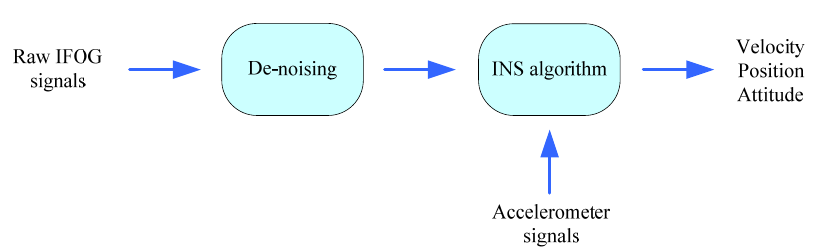
Figure 17. The de-noising of the IFOG signals before the navigation calculation